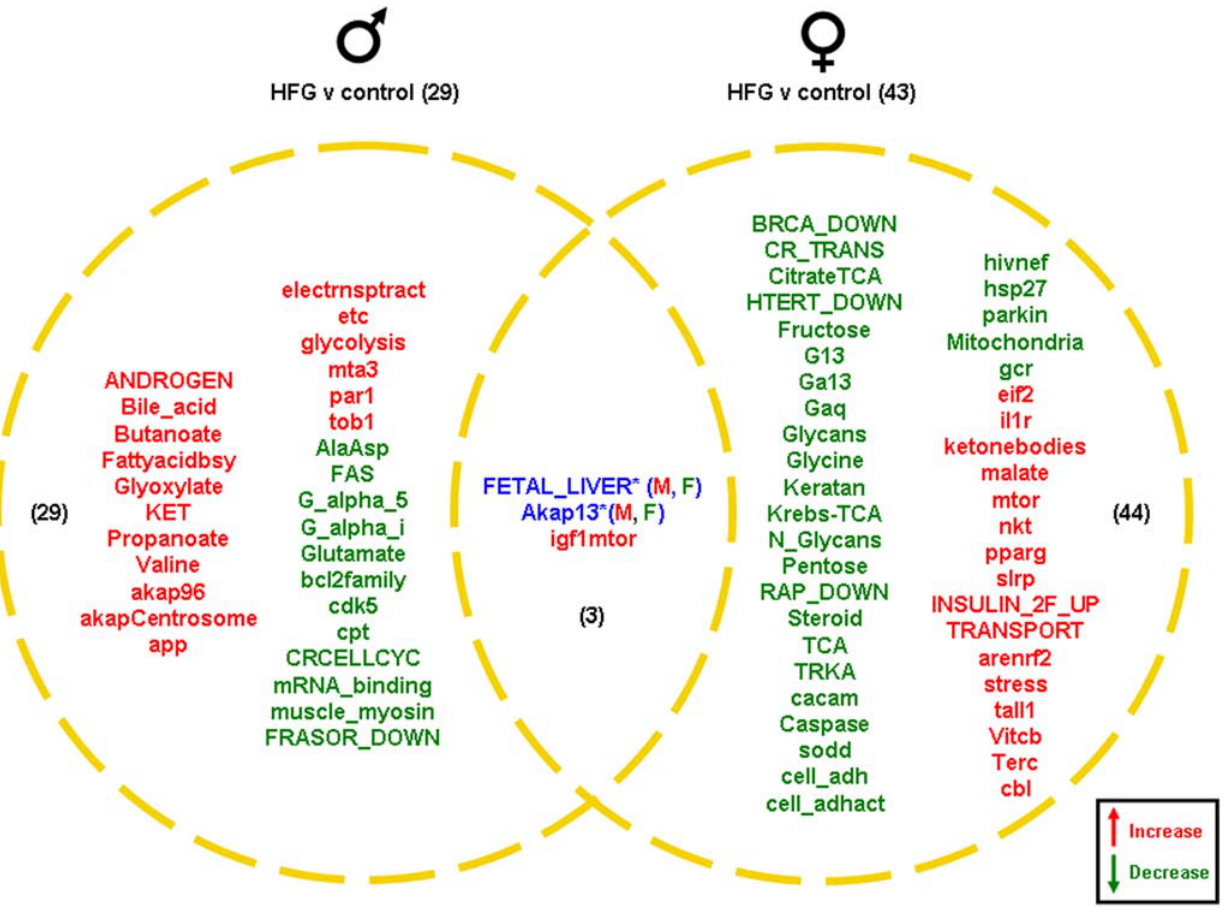
Figure 12. Pathway changes in the gonads of male and female rats maintained on the HFG diet compared to the gonads of male and female rats maintained on a control ( adlibitum ) diet. Significantly regulated, functional pathway clusters were generated from the respective male or female gene sets using PAGE gene set analysis. Pathways that were significantly up-regulated (red) or down-regulated (green) were clustered into a Venn diagram. Pathways in blue were common to both males (M) and females (F) but were differentially regulated. Names of the significantly altered pathways can be found in Table S2.